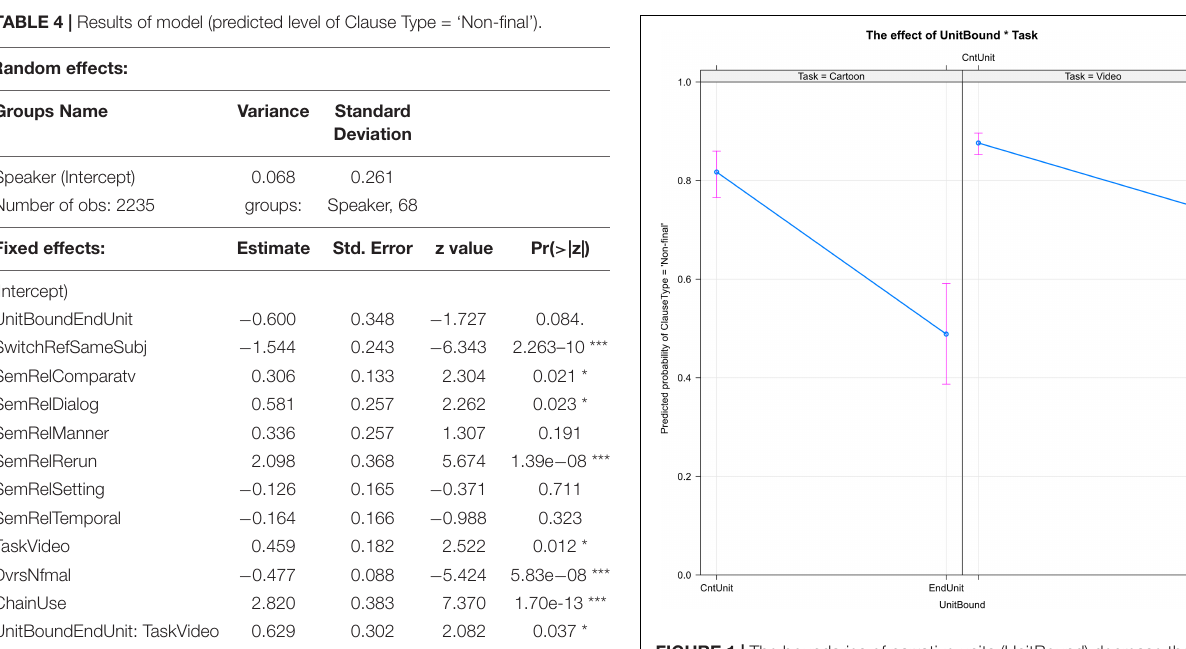
FIGURE 1 | The boundaries of narrative units (UnitBound) decrease the probability of clause linking (ClauseType = ‘Non-final’): the percentage of non-final clauses is higher within narrative units (CntUnit) than at the ends of units (EndUnit). The effect of narrative unit boundaries is stronger in the cartoon task than in the video